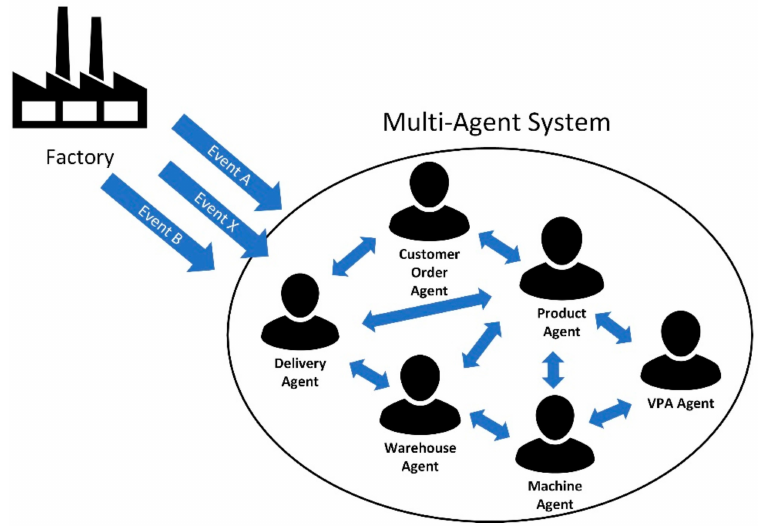
Figure 2. Multi-Agent System main